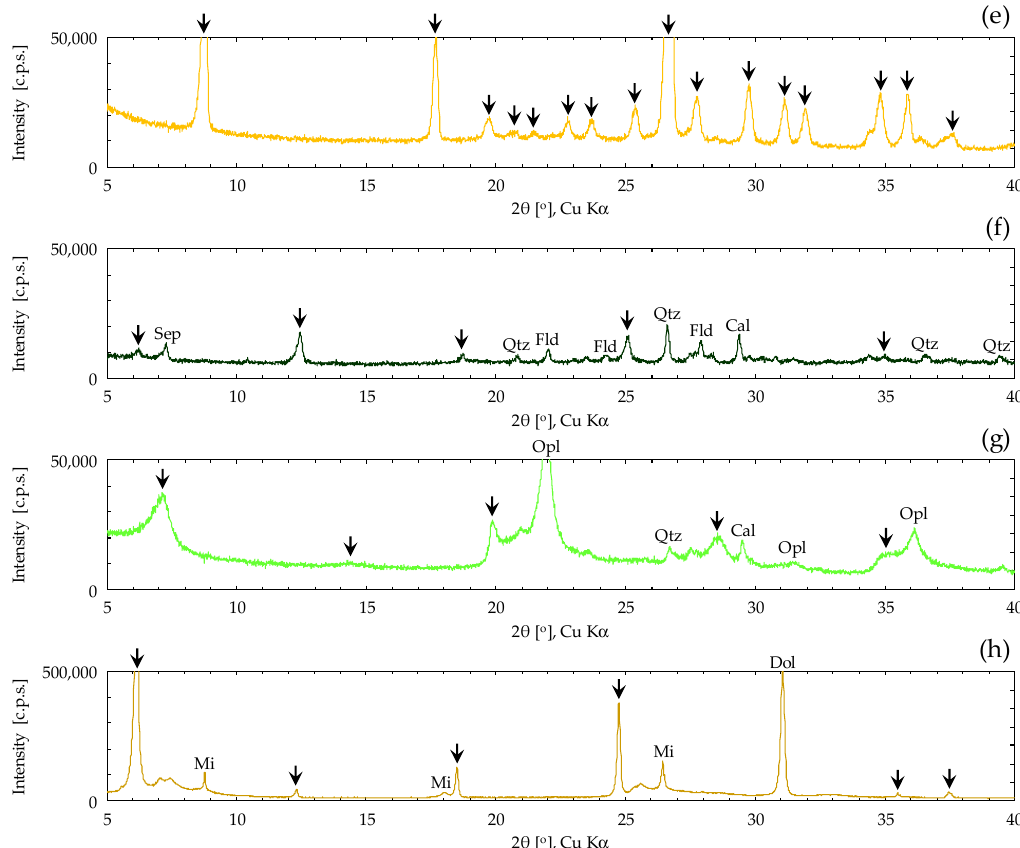
Figure 2. Unoriented X-ray powder diffraction patterns of kaolinite ( a ), 1.0 nm halloysite ( b ), pyrophyllite ( c ), talc ( d ), mica ( e ), chlorite ( f ), smectite ( g ), and vermiculite ( h ) powder samples. The arrows correspond to the index minerals, and abbreviations correspond to other minerals (Cal: calcite, Chl: chlorite, Dol: dolomite, Fld: feldspars, Mi: mica, Opl: opal-CT, Qtz: quartz, Sep: sepiolite).